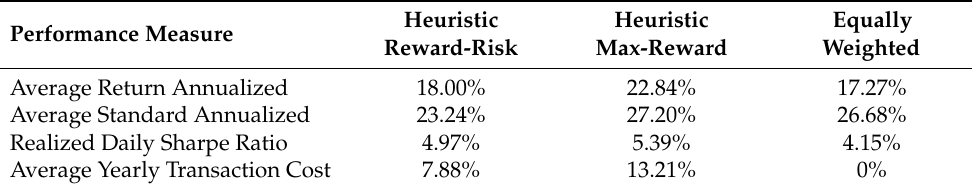
Table 1. Summary out-of-sample investment performance for the 100 stocks.